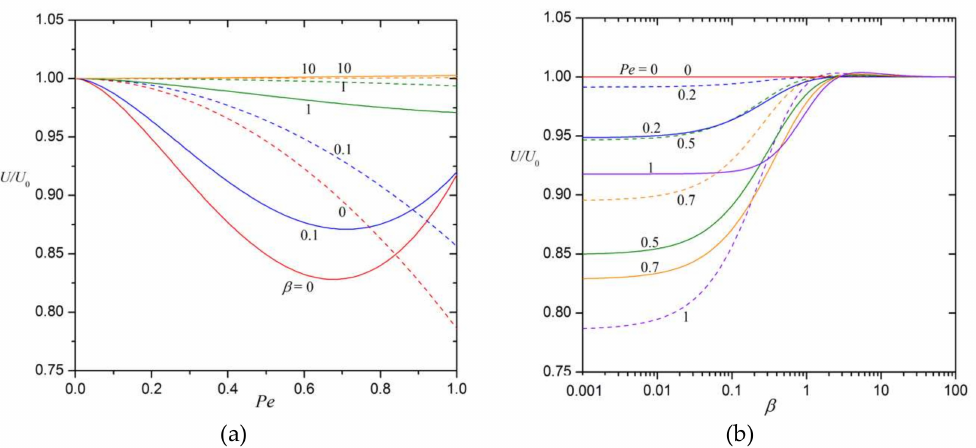
Figure 3. The normalized di ff usiophoretic velocity U / U 0 of colloidal particles ( a ) versus the P é clet number Pe for various values of the polarization parameter β ; ( b ) versus β for various values of Pe . The solid and dashed curves are plotted for a circular cylinder and a sphere,